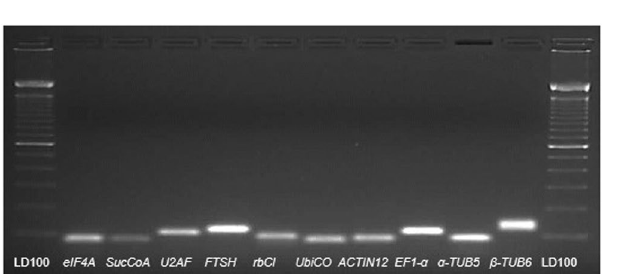
Figure 1. Melting curves of PCR products from all reference genes used in this study showing a single peak (each includes two technical replicates of the cDNA pool from all samples).